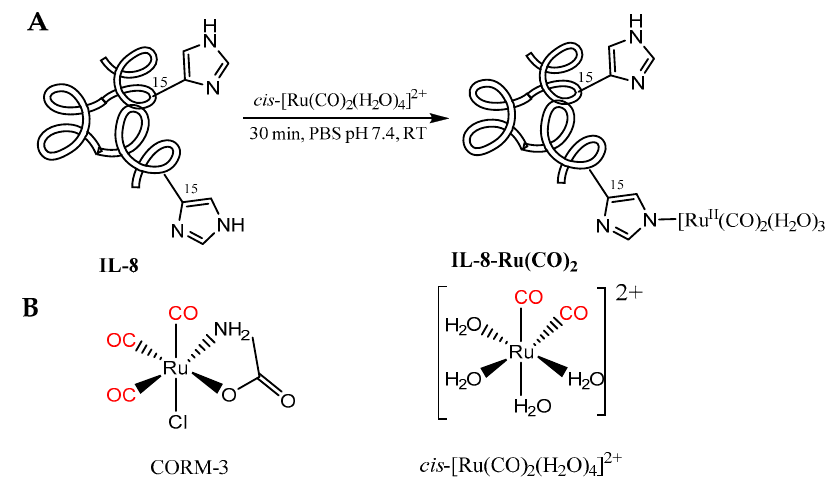
Figure 15. The spontaneous CO release by metalloprotein: ( A ) The carbonyl reagent cis -[Ru(CO) 2 (H 2 O) 4 ] 2 + spontaneous CO release in live cells using histidine (His) metalloprotein and retained at IL-8; ( B ) the cis -[Ru(CO) 2 ] 2 + carbonyl segment can be produced by the aqua carbonyl cis -[Ru II (CO) 2 (H 2 O) 4 ] 2 + .